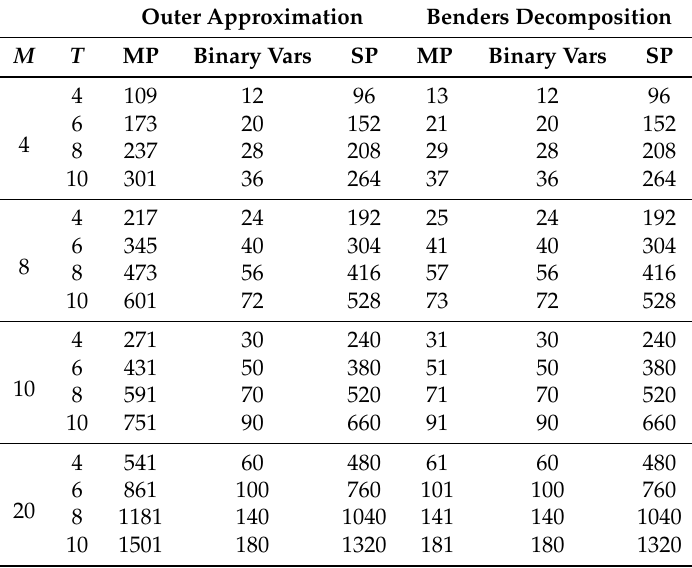
Table 2. Number of variables of synthetic problems with binary variables, for analysis of decomposition strategies. Column “MP” stands for the number of variables in the master problem, “Binary vars” corresponds to the binary variables of the master problem, and “SP” is the number of variables in the subproblem.